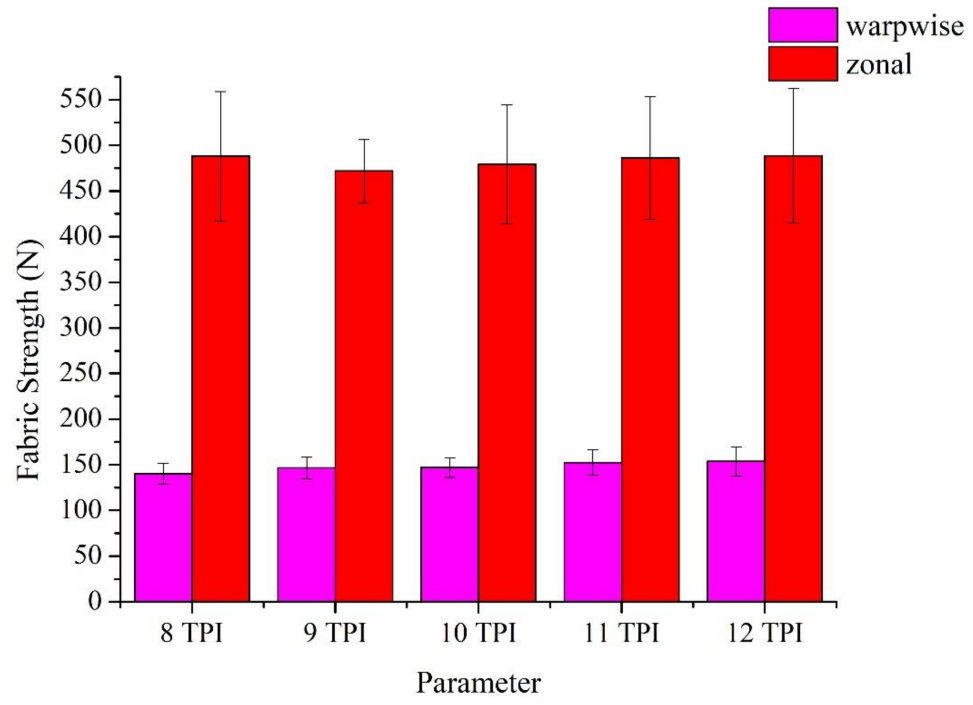
Figure 6. Tensile strength of non-woven fabrics composed of the Ge/SS core-spun